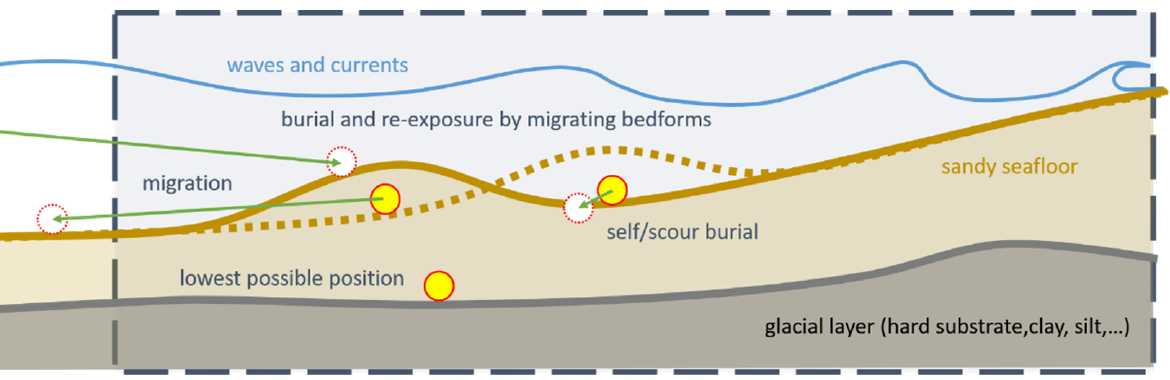
Figure 1. Conceptual drawing of possible processes of burial, re-exposure, and migration of UXO in the area of interest. Yellow circles with red outline represent the original position of the UXO, white circles with dashed red outline represent the position after migration, with the direction indicated by a green arrow.